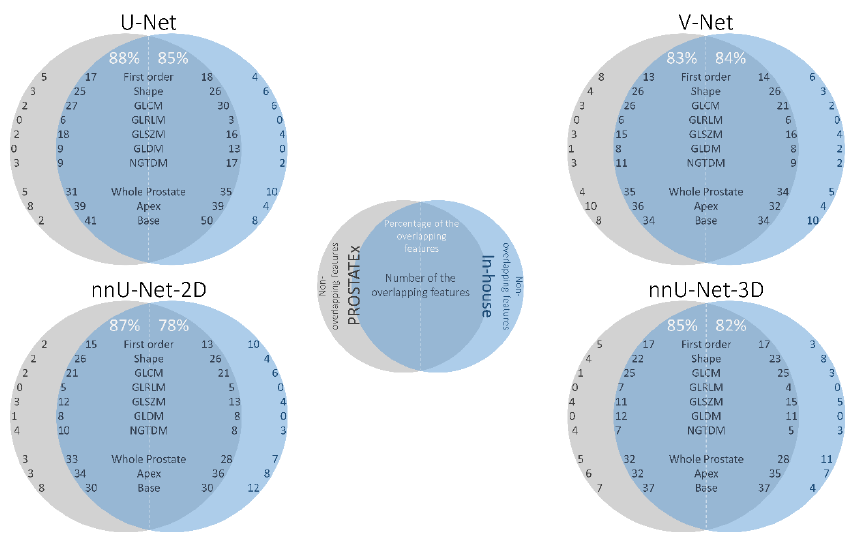
Figure 5. The overlap between the features in the PROSTATEx (gray) and in-house (blue) datasets of the same segmentation method (e.g., overlap between the “PROSTATEx—U-Net model” and “In-